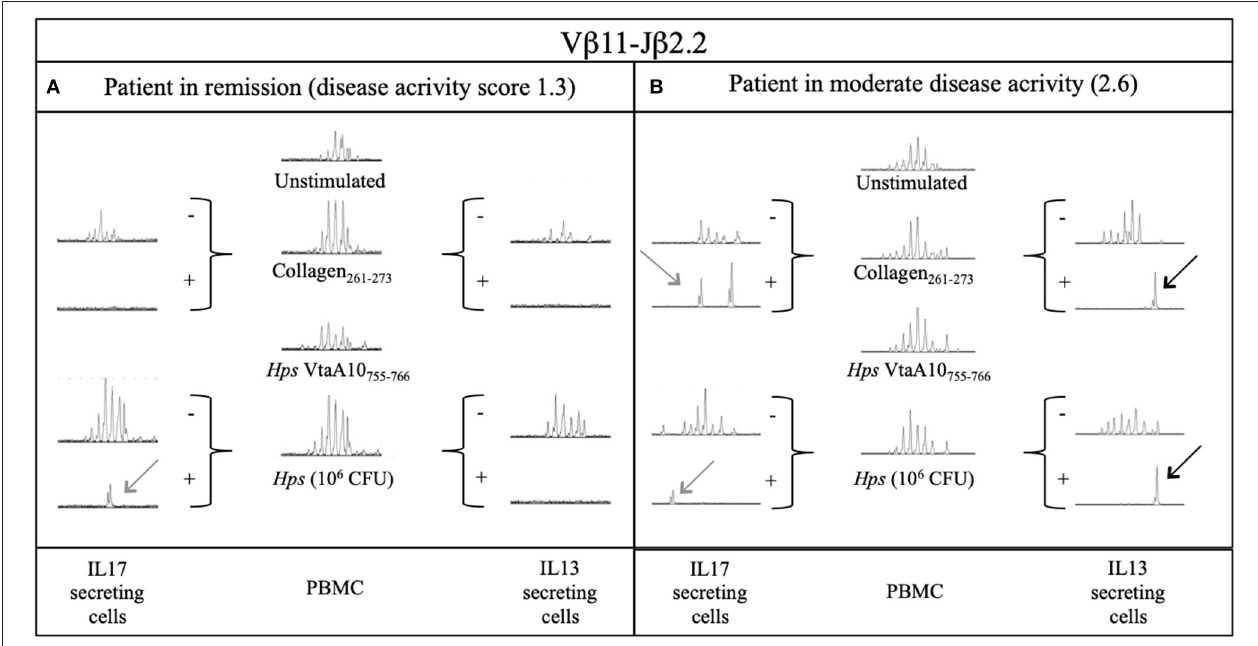
FIGURE 4 | Secretion of IL17A and IL13 by V β 11-J β 2.2 rearrangement from two DR4 + ERA patients after stimulation with Collagen and live Hps. PBMC samples and sorted IL17 and IL13 secreting T cells from 2 ERA patients with different disease activity (DAS): (A) one in remission and (B) the other during active phase of disease were compared through Immunoscope analysis. The presence of an antigen-specific expansion is displayed with a perturbation of the gaussian or the presence of a single peak where possible the comparison could be done through the rate between the area of the same length peaks of two different samples (RSI, rate stimulation index). Hps, Haemophilus (Glaesserella) Parasuis; CFU, Colony Forming Unit; IL17, Interleukin 17; IL13, Interleukin 13; VtaA, virulence-associated trimeric